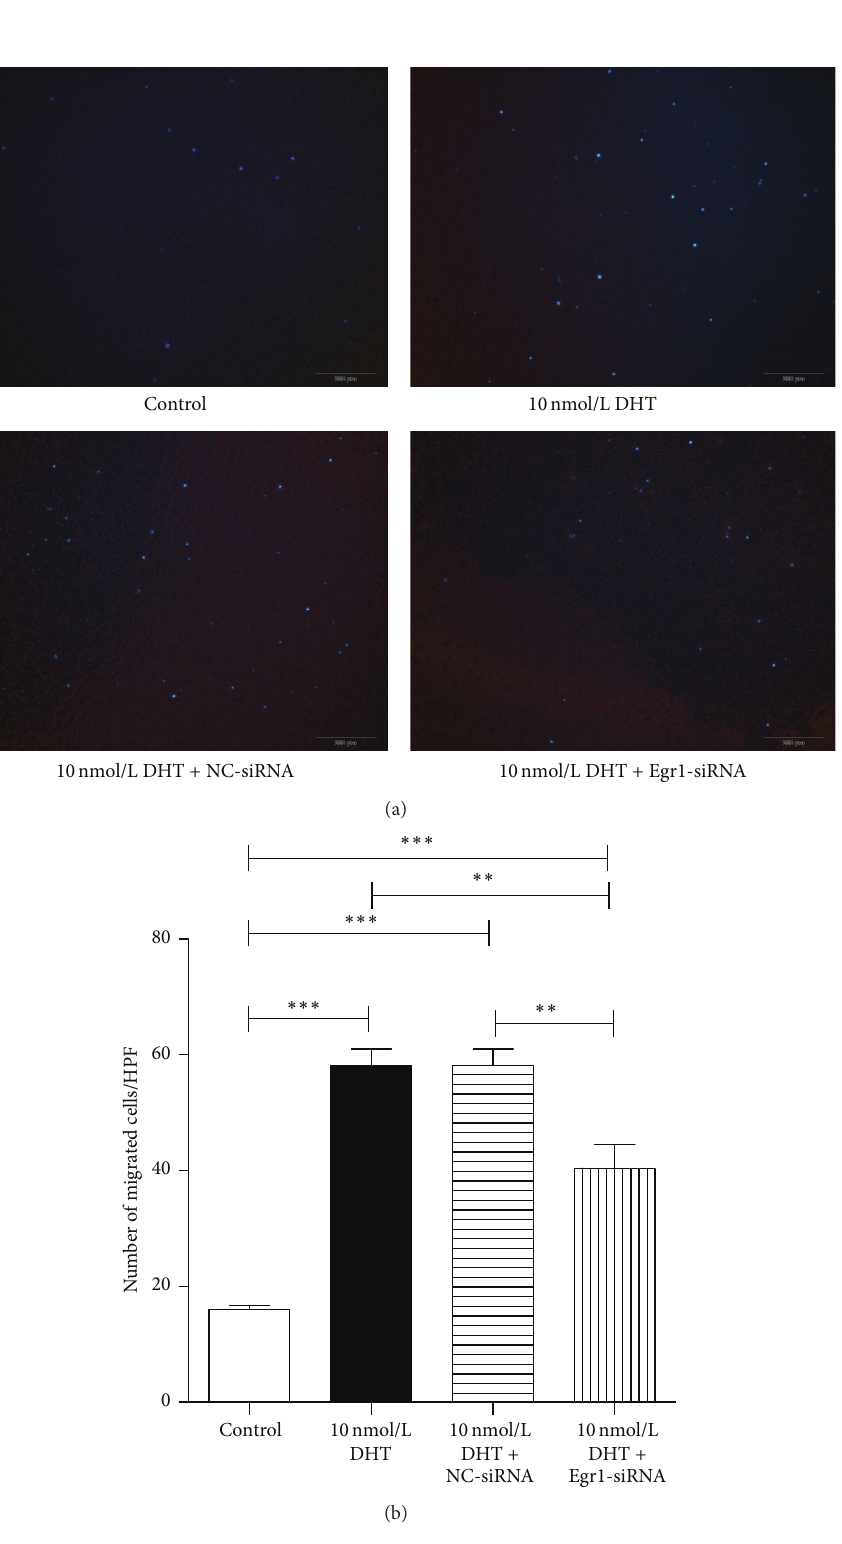
Figure 10: The transwell assay of Egr1-silenced EPCs. The increased migratory capacity of EPCs by DHT treatment was also blocked by Egr1- siRNA transfection. (a) Transwell migration assay was employed to examine the migration ability of DHT-treated EPCs after transfection of Egr1-siRNA or control. (b) The migrating EPCs were counted and averaged at high power field. All assays were triplicated and demonstrated similar results. Data are presented in mean ± SD format. ∗∗ 𝑃 < 0.01 versus control group, ∗∗∗ 𝑃 < 0.001 versus control